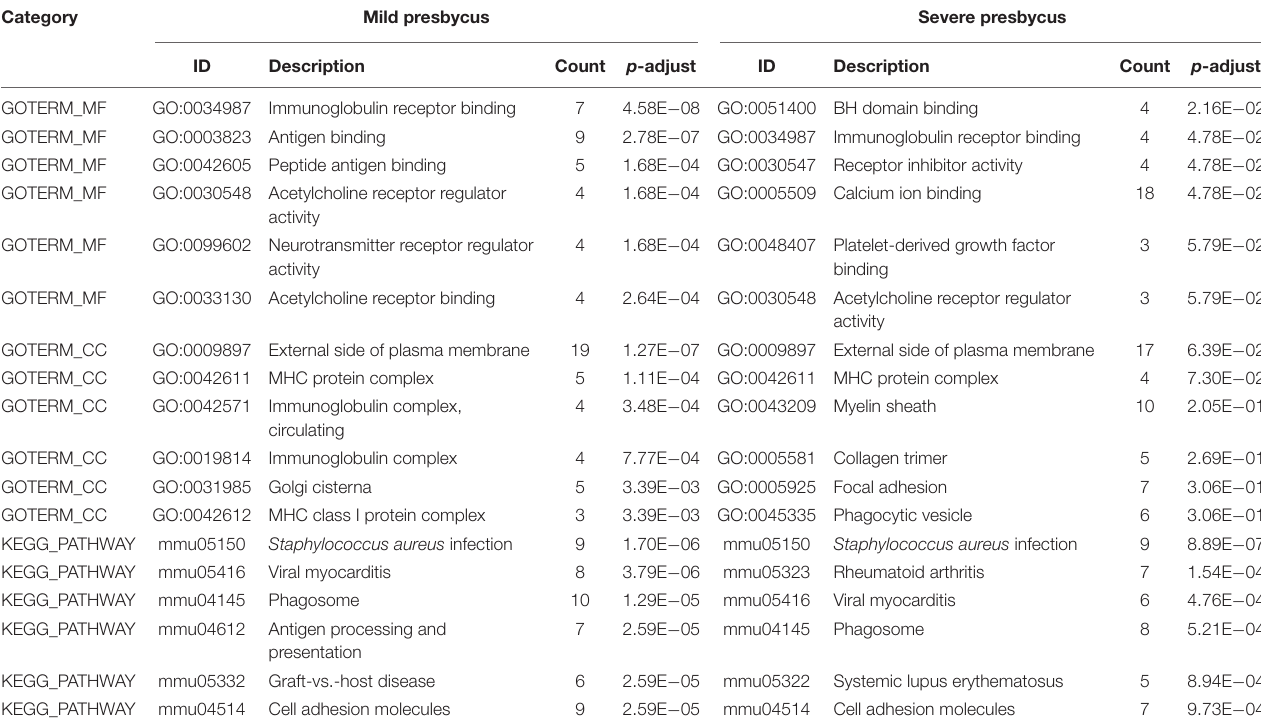
TABLE 2 | Gene ontology (GO) and Kyoto Encyclopedia of Genes and Genomes (KEGG) pathway enrichment analysis of differentially expressed genes (DEGs) in the most significant module. Category Mild presbycus Severe presbycus